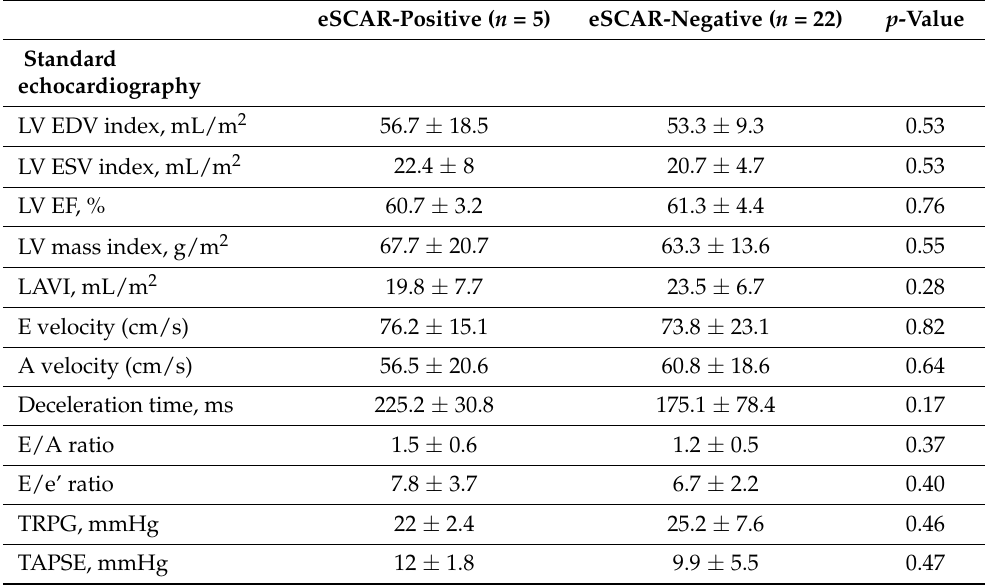
Table 2. Standard echocardiographic and myocardial strain data in patients with SLE stratified by positivity of eSCAR imaging